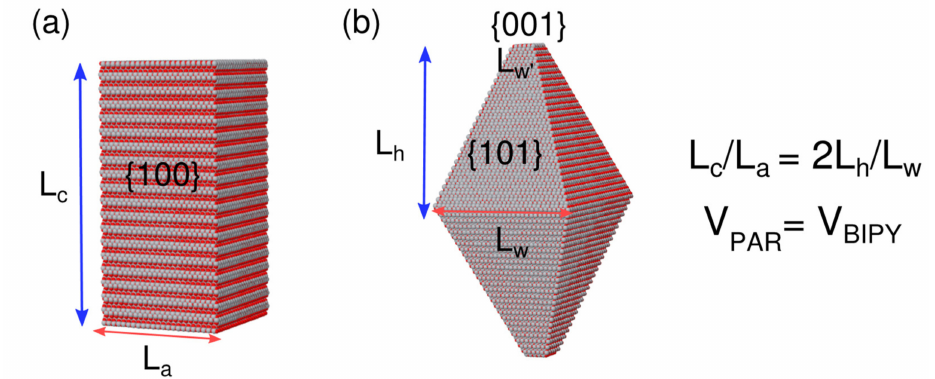
Figure 1. ( a ) A tetragonal square prism, characterized by L a and L c descriptors; ( b ) a tetragonal truncated square bipyramid, characterized by L w , L w’ , and L h descriptors. Lateral faces in ( a ) are {100}, inclined faces in ( b ) are {101}, and basal faces are {001} in both